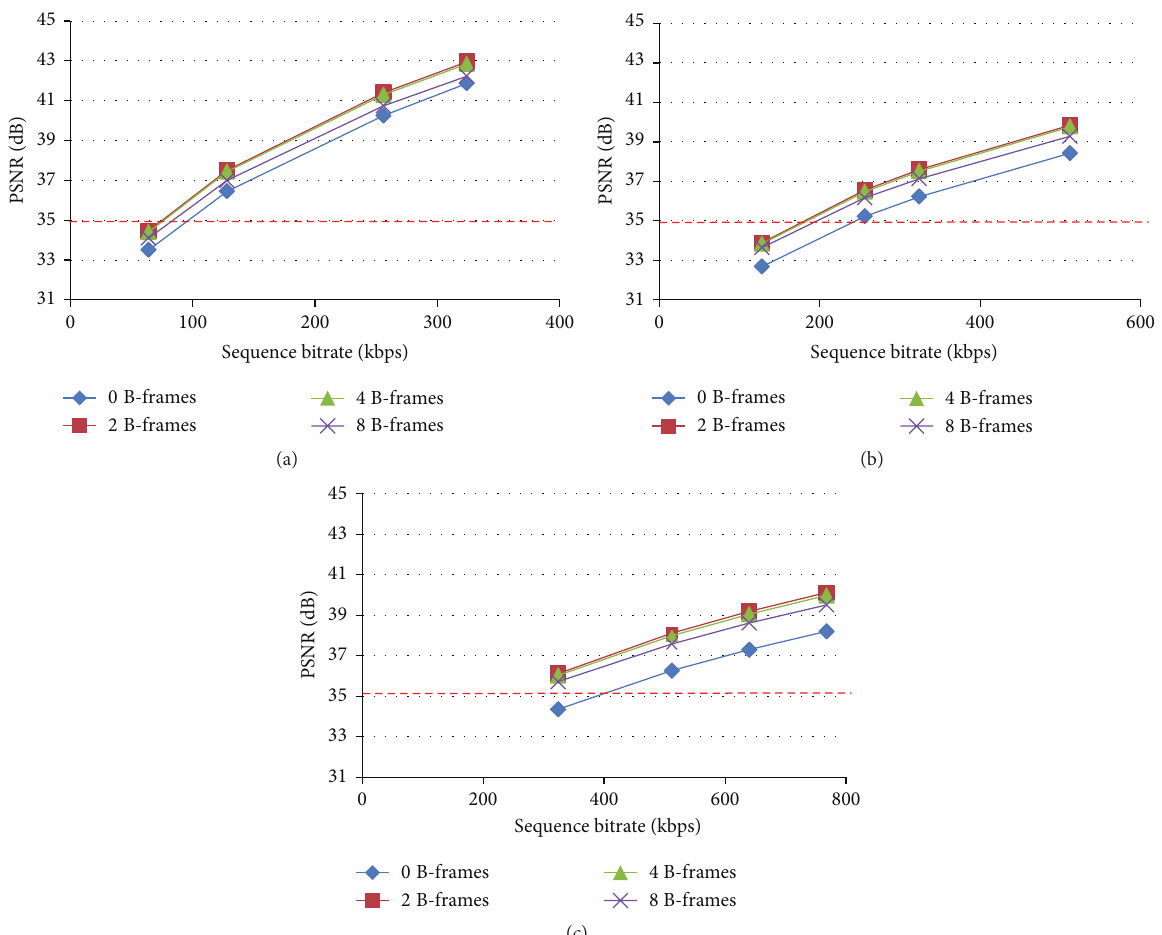
Figure 3: Rate-distortion curves demonstrating coding structure’s efficiency at different resolutions and bitrates, for a typical atherosclerotic plaque ultrasound video. (a) QCIF (176 × 144) resolution, (b) CIF (352 × 288) resolution, and (c) 560 × 416 (clinically acquired)